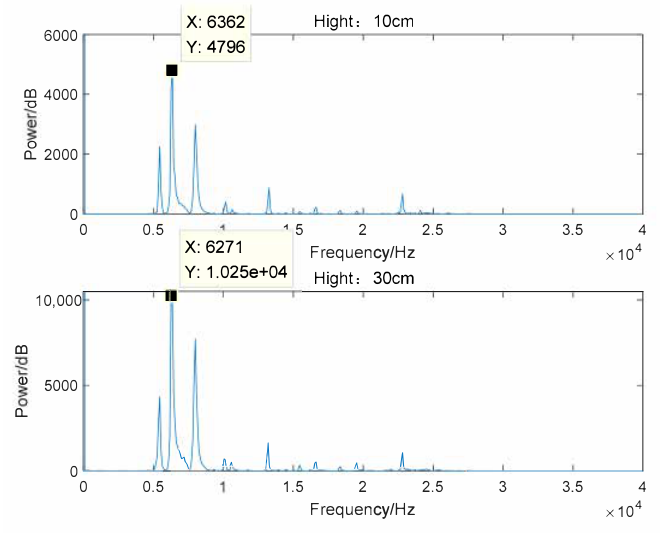
Figure 9. Impact power spectrum curves of 10 cm and 30 cm